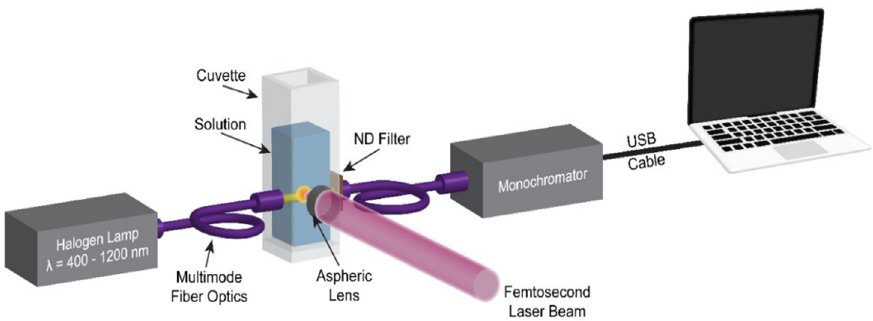
Figure 1. The schematic set-up of the nanoparticle synthesis.